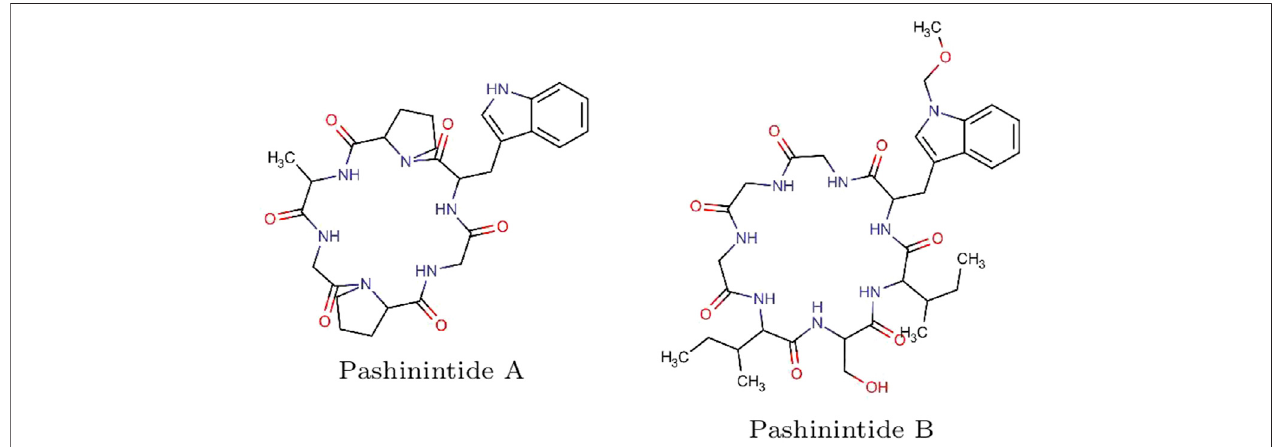
FIGURE 1 | Graphical sketches of the molecular structures of the Pashinintides A and B plant cyclopeptides.